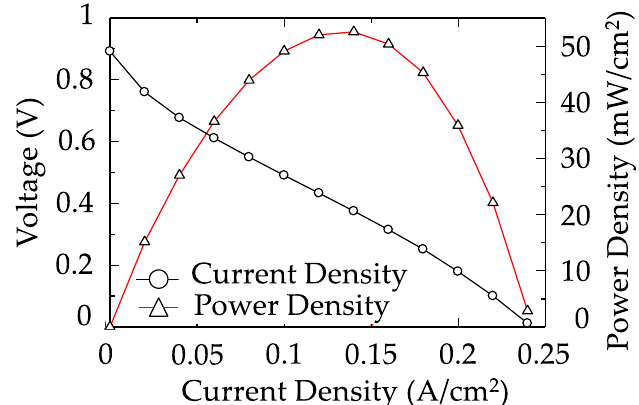
Figure 6. Current density and power density of a fabricated membrane electrode assembly (MEA) using Pt nanoparticle-supported nanographene as a catalyst layer.